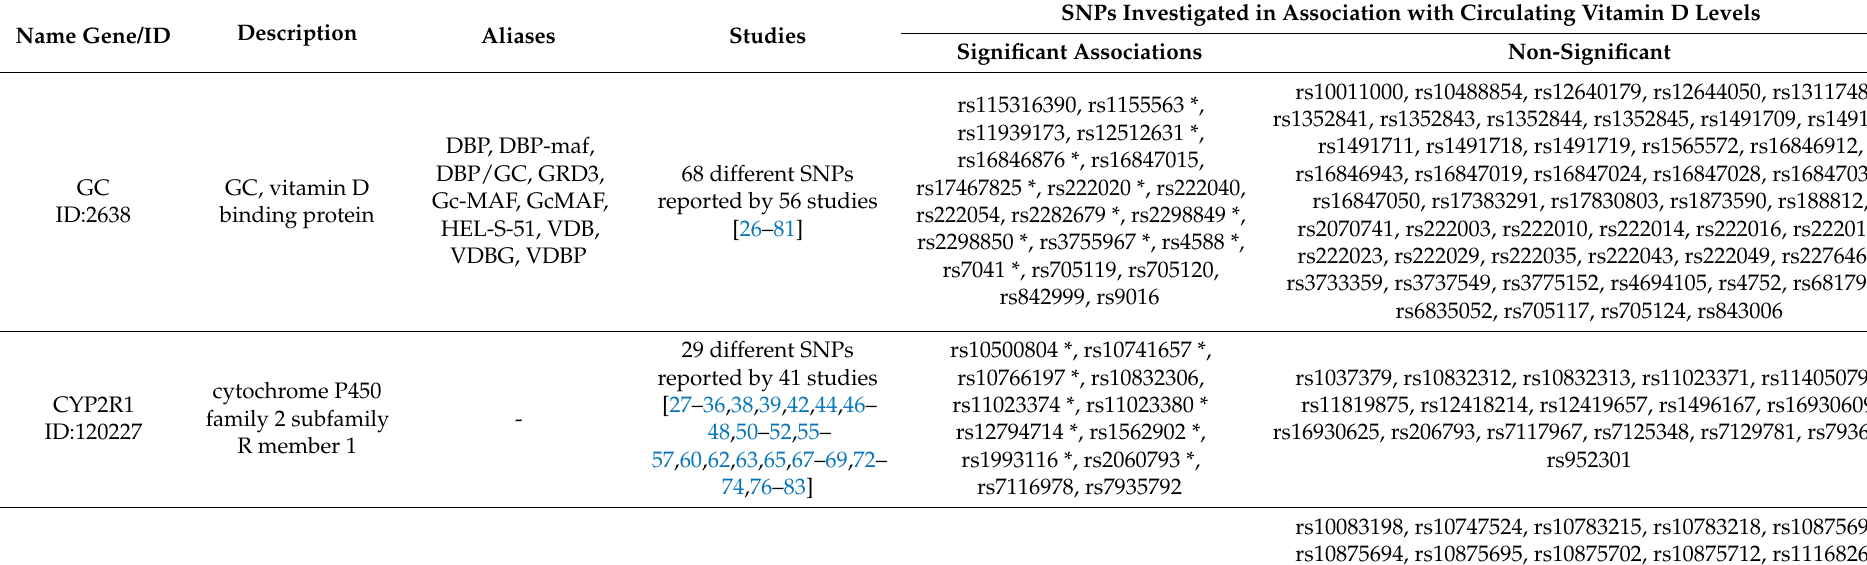
Table 1. SNPs in vitamin D pathway-related genes and vitamin D